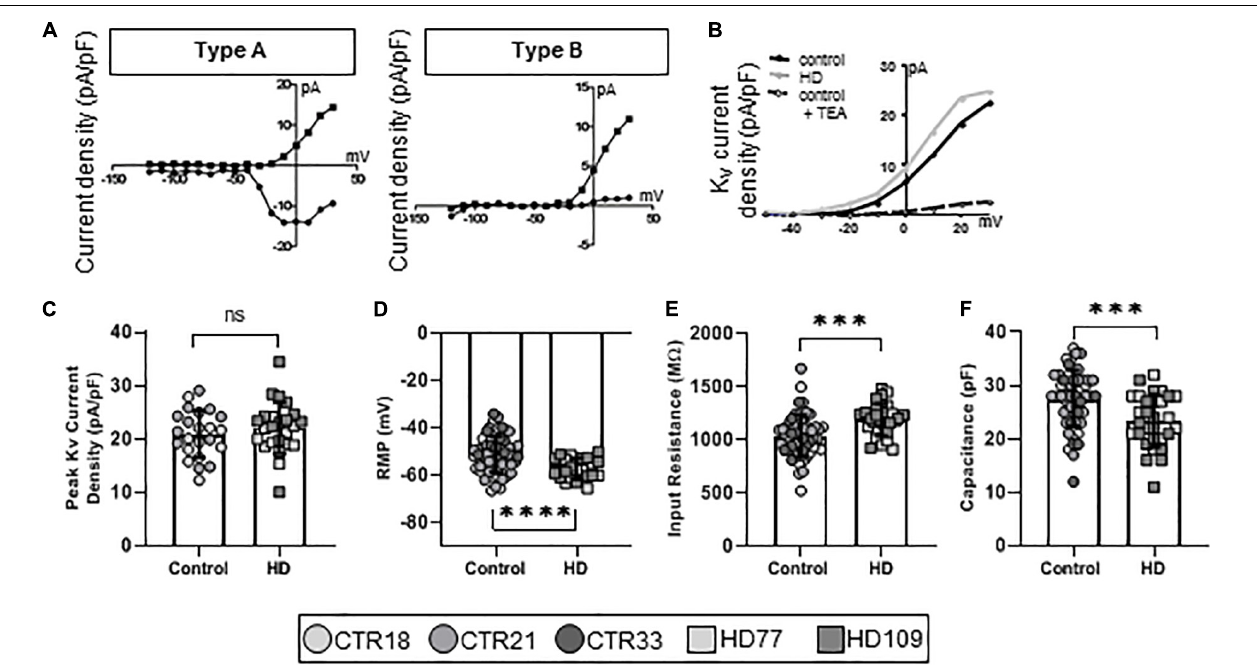
FIGURE 2 | Stages 3 and 4 HD iPSC-derived astrocytes display reduced capacitance as committed but immature Type A/B astrocytes. (A) iPSC-derived astrocytes mature from astrocyte progenitors expressing voltage-gated Na + and K + currents (Type A, left), to immature astrocytes expressing some voltage-gated Na + but mostly voltage-gated K + currents (Type B, right). (B) Example current-voltage (IV) curve of voltage-gated K + current density from HD, control and control + TEA in Type A/B astrocytes. (C) Immature astrocytes display no differences in the peak voltage-gated K + current density between HD and control. (D) Type A/B HD astrocytes have more hyperpolarized resting membrane potentials compared to control and (E) higher input resistance. (F) Immature HD astrocytes show smaller capacitances compared to controls. Each cell is represented as a single point, and therefore N is represented on each graph. These cells were analyzed from more than three separate experiments ( ∗∗∗ p < 0.005 and ∗∗∗∗ p <